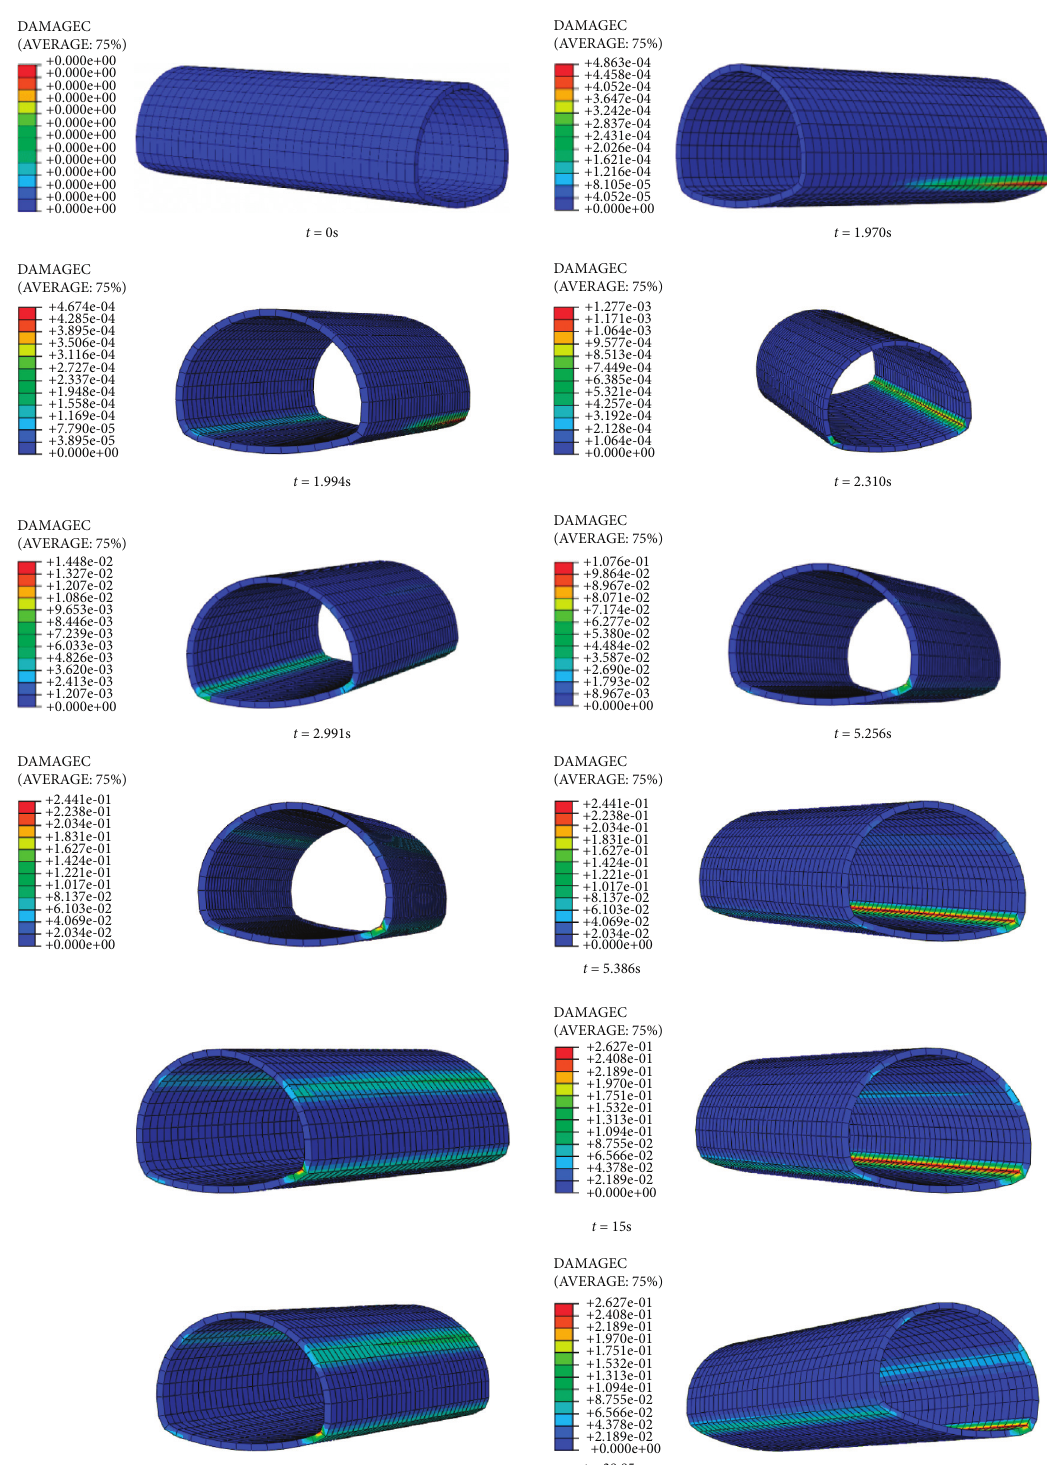
Figure 14: Damage map of tunnel